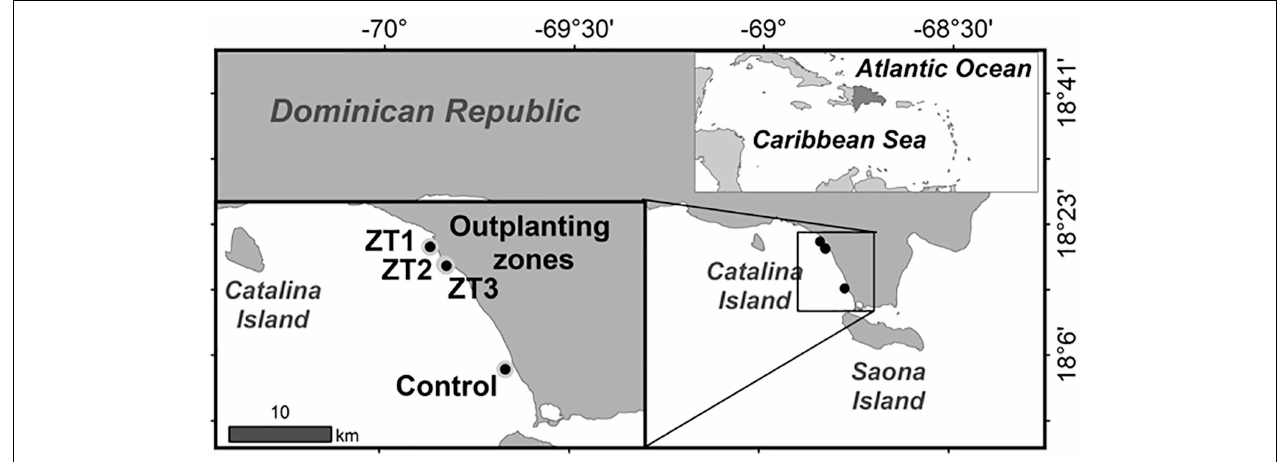
FIGURE 1 | Map of outplanted sites and control site part of the Arrecifes del Sureste Marine Sanctuary.